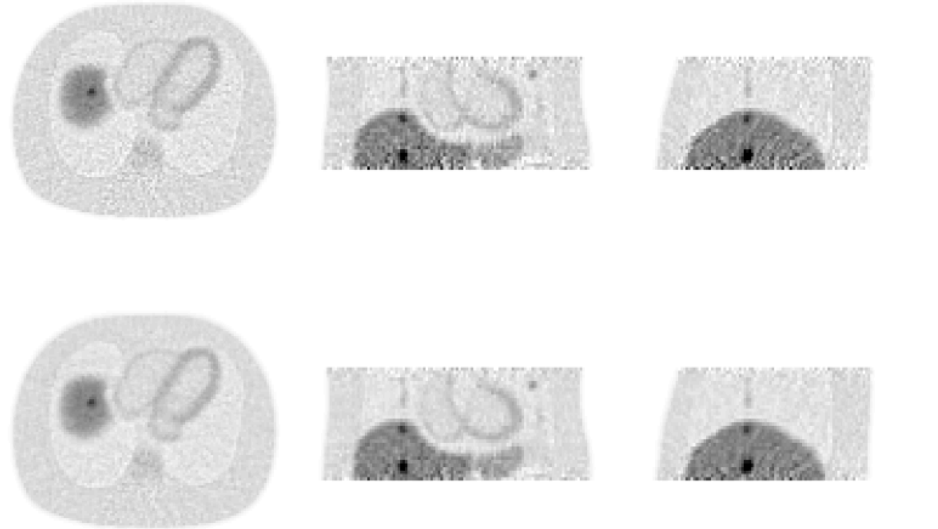
Figure 5. Transverse, coronal, and sagittal planes for PET images of the NCAT phantom reconstructed from noisy data with MC-OSSPS (top row) and R-MC-OSSPS (bottom row). Both images used 40 iterations with 12 subsets. Post-smoothing was not applied. The linear greyscale is thresholded at a standardized uptake value (SUV) equal to 6.